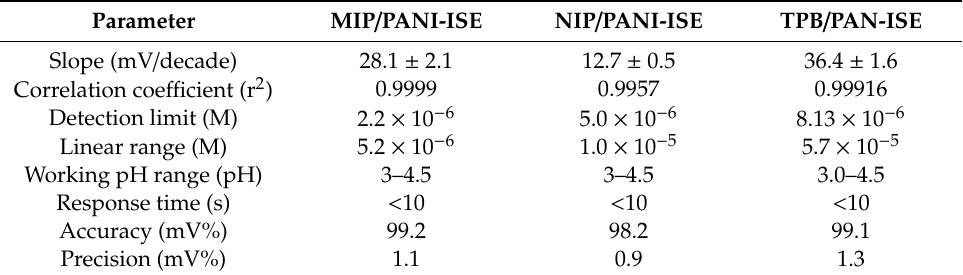
pot k , ) of CYR membrane sensors plasticized with BCYR